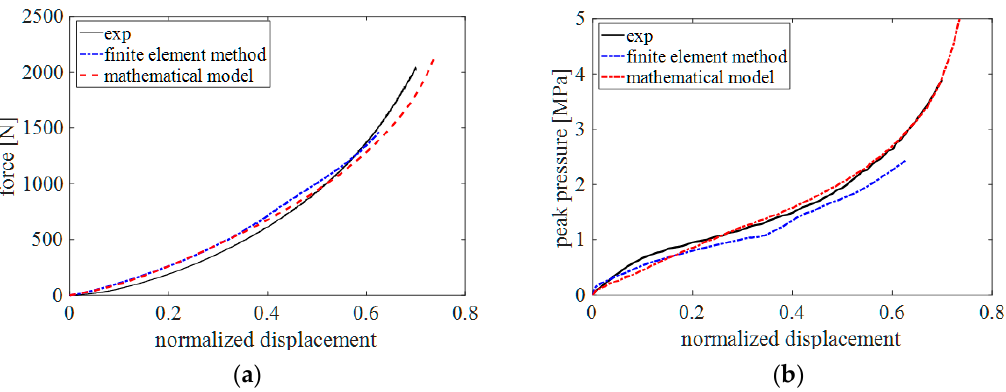
Figure 4. Comparison of mathematical model, FE model and experiment: contact force ( a ) and peak pressure ( b ).